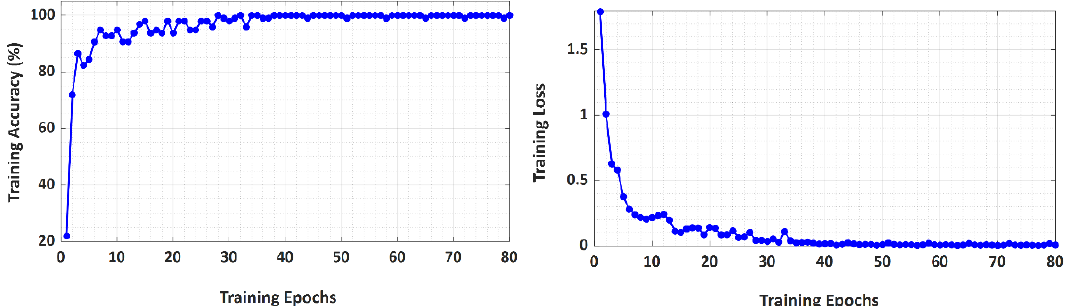
Figure 10. Convergence curves of the fault classification unit during the training process.